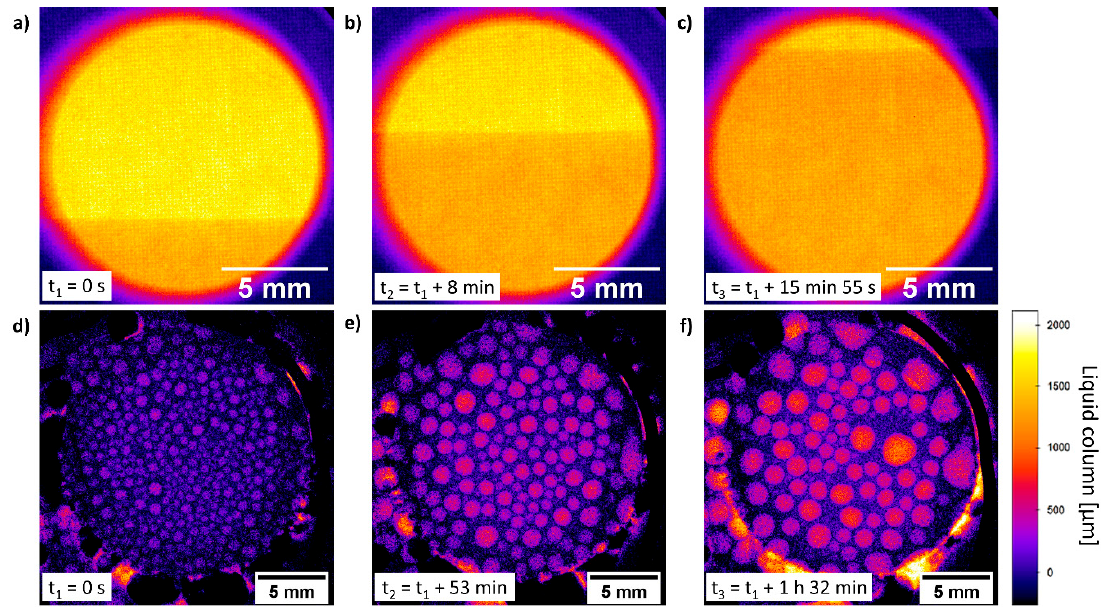
Figure 7. ( a – c ) Flooding process of the 2 nd Gen. cell, recorded using a lab-scale micro-CT. (technical ODC, 30 wt.% NaOH solution); ( d – f ) in-operando radiography measurements at 75 °C.